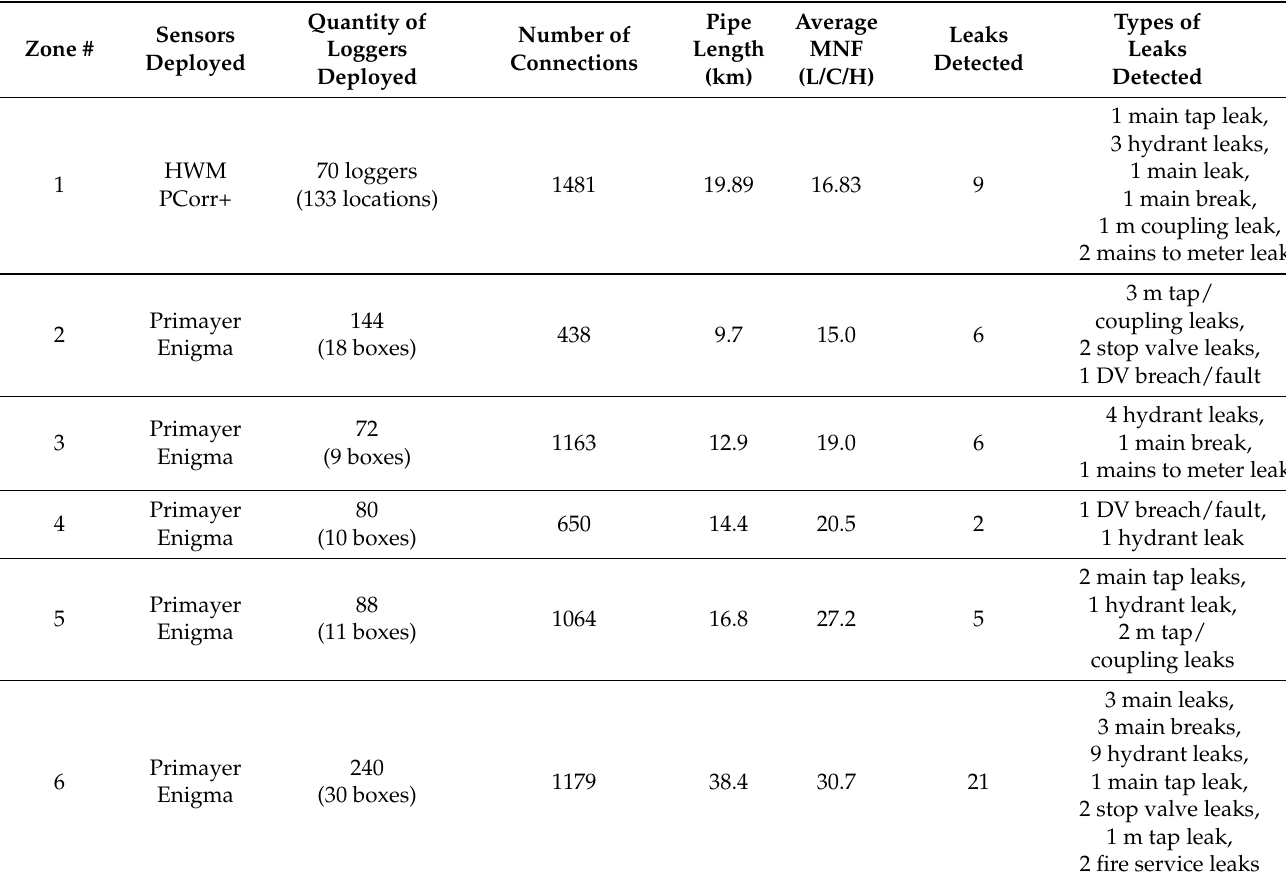
Table 1. Lift and Shift Vibro-Acoustic Logger Deployment